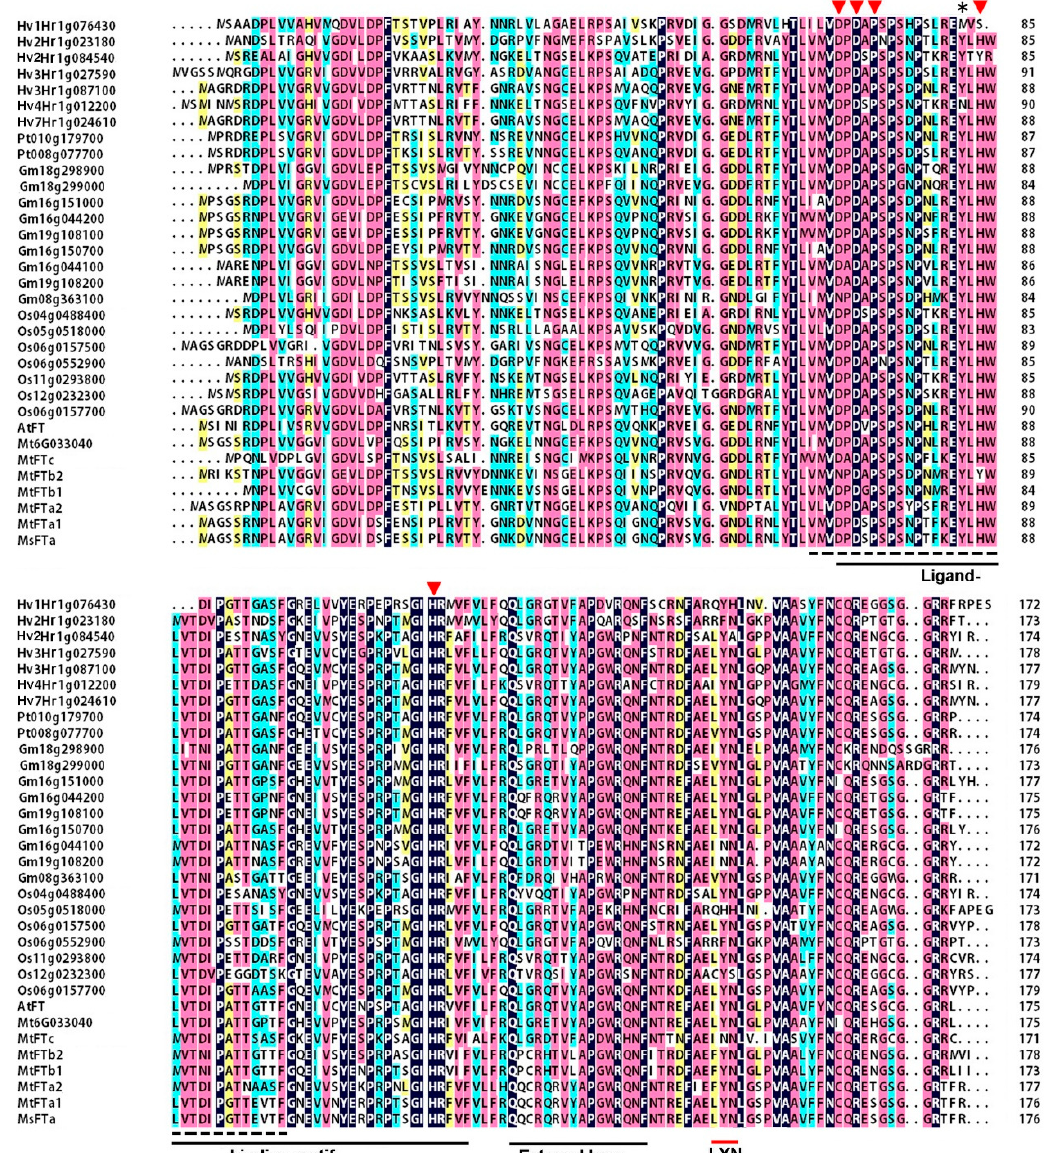
Figure 2. Sequence alignment of FTs in the indicated species. Sequence was aligned using DNAMAN Version 7 (Lynnon Corporation, Quebec, Canada). Homology level was highlighted by shading in color: black for 100%, pink for ≥ 75%, blue for ≥ 50% and yellow for ≥ 33% identity. The ligand-binding motif and the external loop of 14-amino acid stretch are underlined. The amino acid residues encoded by exon 2 (62 bp) and exon 3 (41 bp) are underlined with a dashed line. Triangles indicate the conserved amino acids in the ligand-binding pocket. An asterisk (*) indicates the conserved key residue Tyrosine (Y) at position 85 of MsFTa .